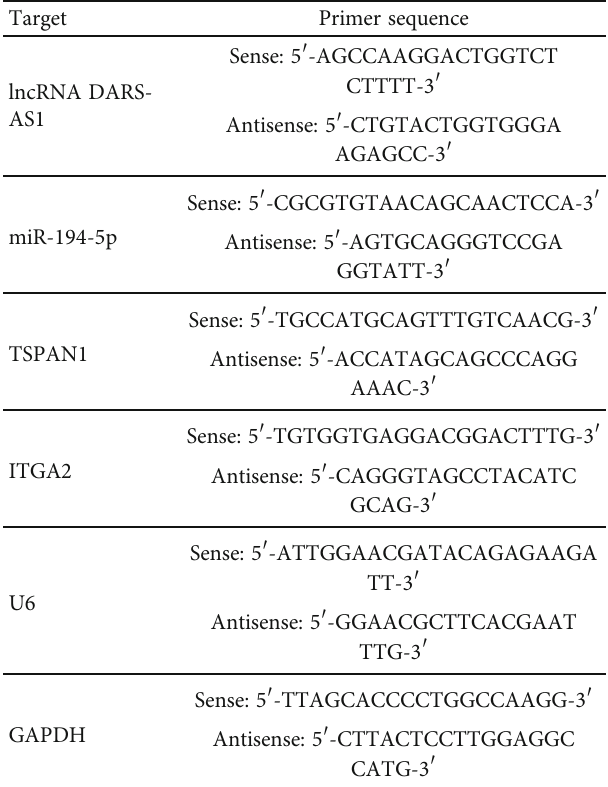
Table 1: Primer sequences for